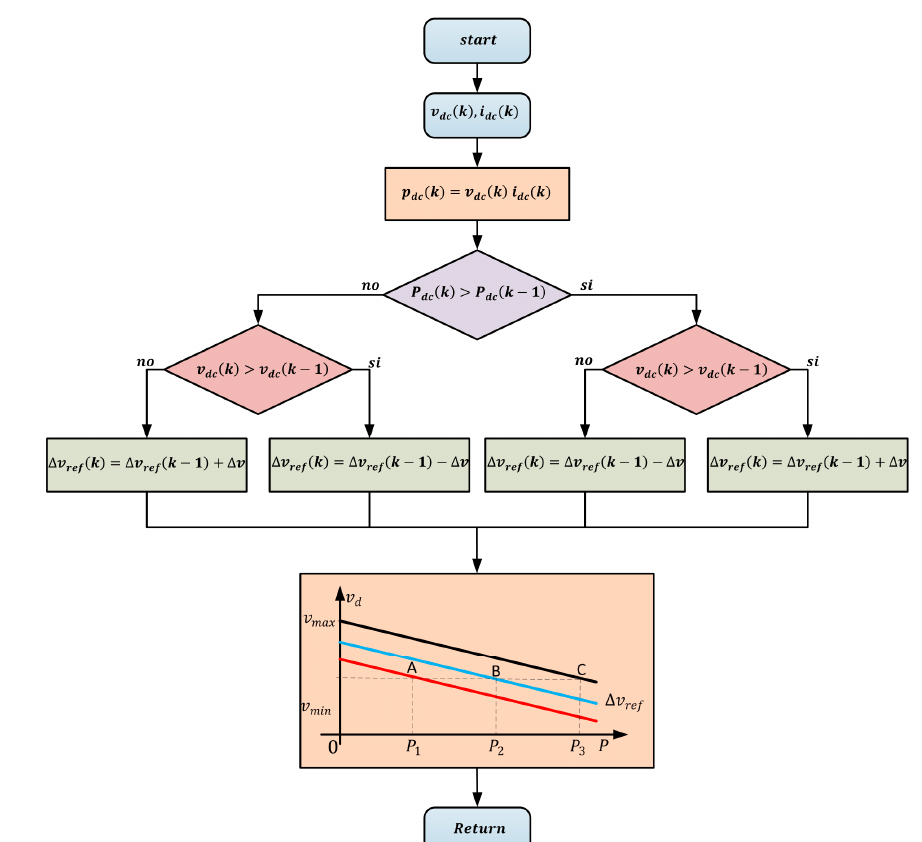
Figure 8. Flow diagram of the P&O MPPT algorithm. The parameters of the simulated PV modules are those of the commercial panel SunPower model SPR-415E-WHT-D and are summarized in Table 3.